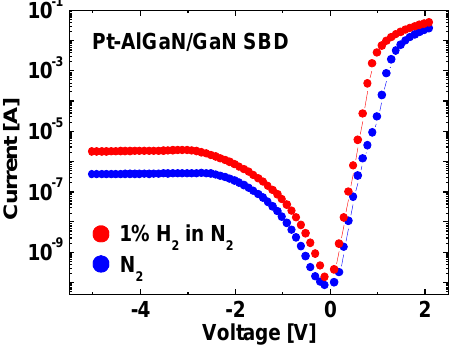
Figure 10. I–V characteristics of the device in N at room temperature. Reproduced with permission from Reference [37].